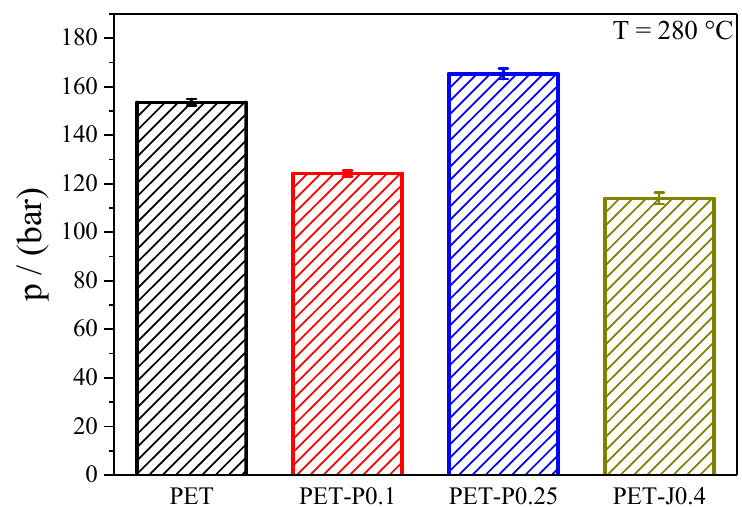
Figure 7. Extrusion pressure in the metering zone for PET modified with PMDA or Joncryl during the film blowing experiments.